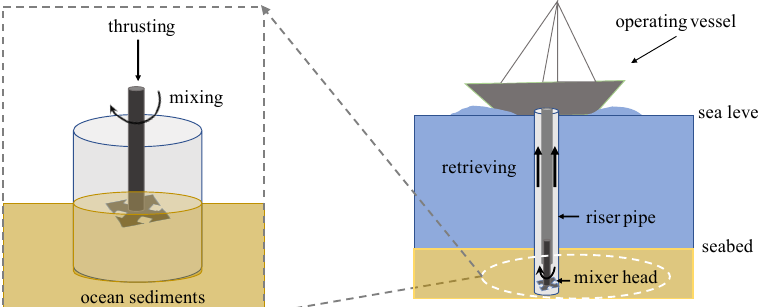
Figure 1. Schematic diagram (not drawn to scale) illustrating a mixing process for offshore mining: the mixing process under the seabed increases the transportability of sediments for retrieving mineral resources via pipes connected to an operating